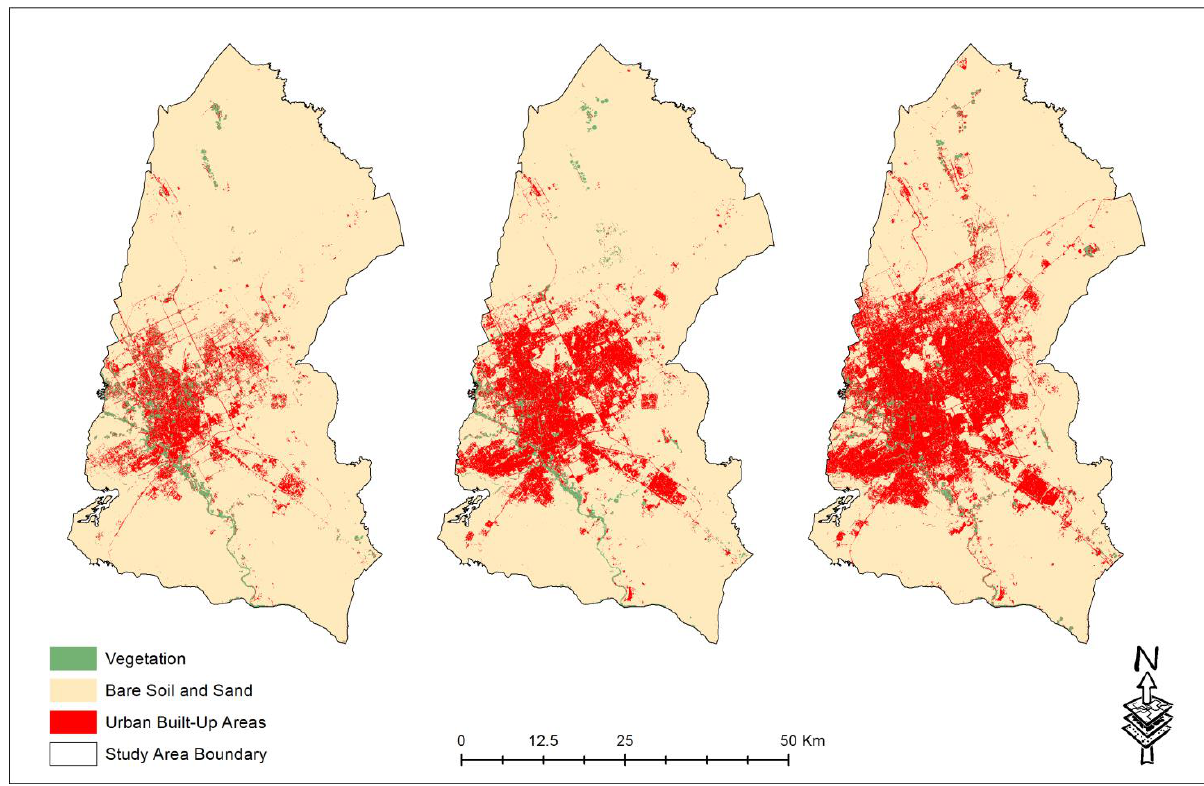
Figure 2. LULC in the study area in 1990 (left), 1998 (center), and 2009